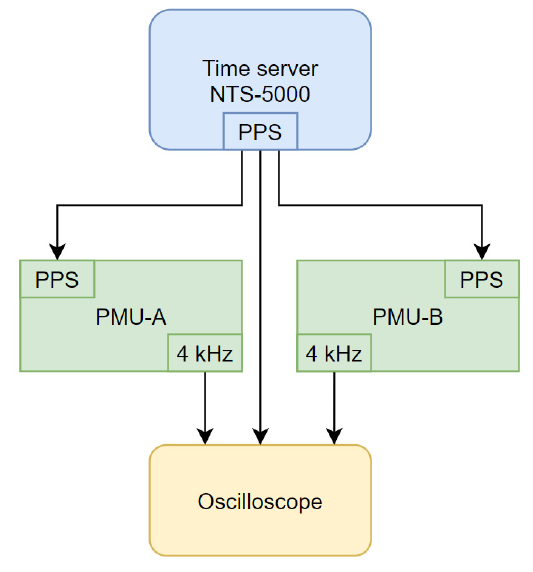
Figure 9. Experimental setup for sampling signal quality measurements.